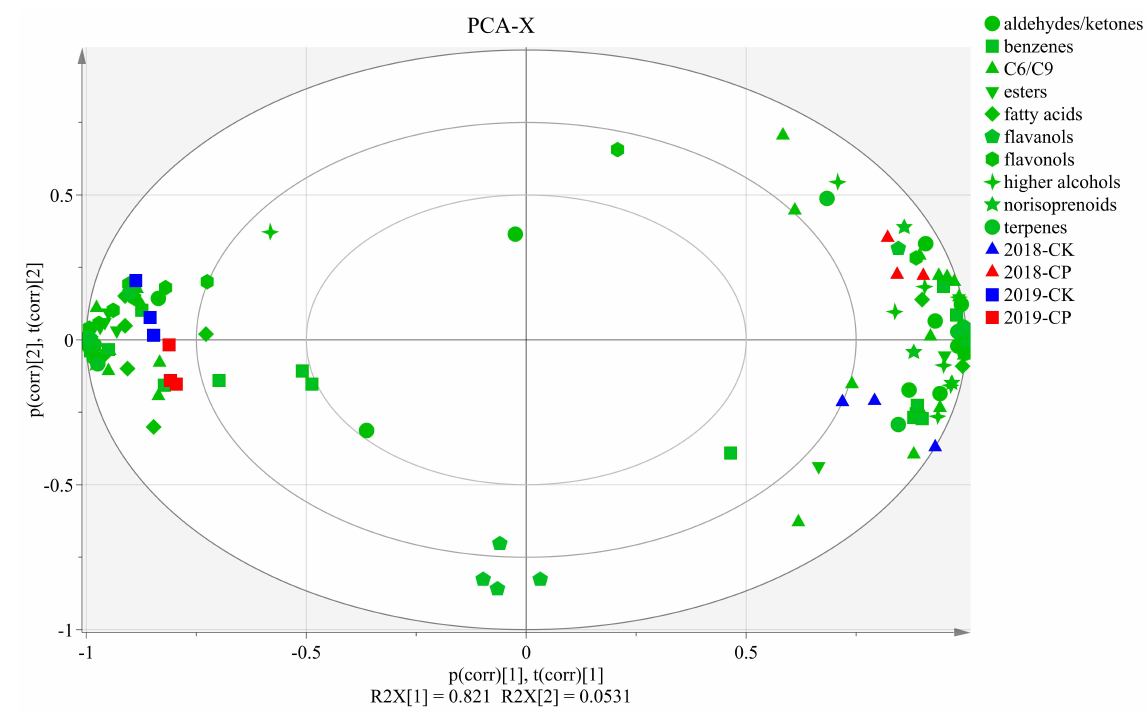
Figure 7. PCA analysis based on aroma compounds and flavonoid compounds by CK and CP in 2018-2019.